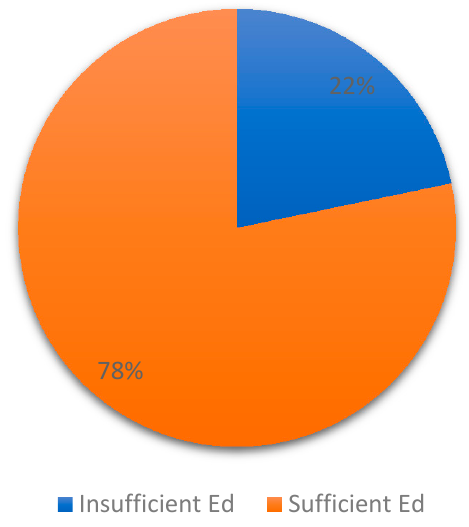
Figure 14. Percentage of regions with insufficient Ed.